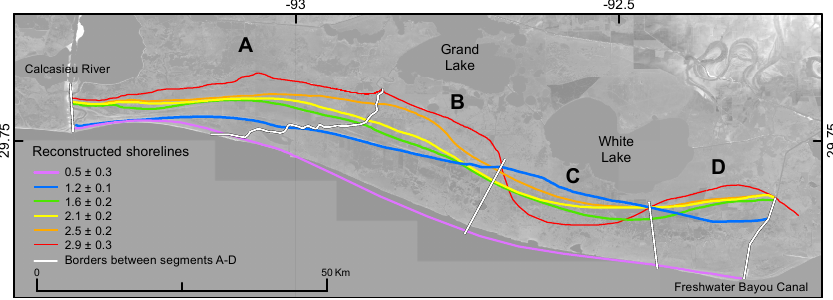
Figure 13. Six palaeo-shorelines reconstructed from the Chenier Plain, along with the location of coastal segments A–D. See Table S2 for background information on the chronology.